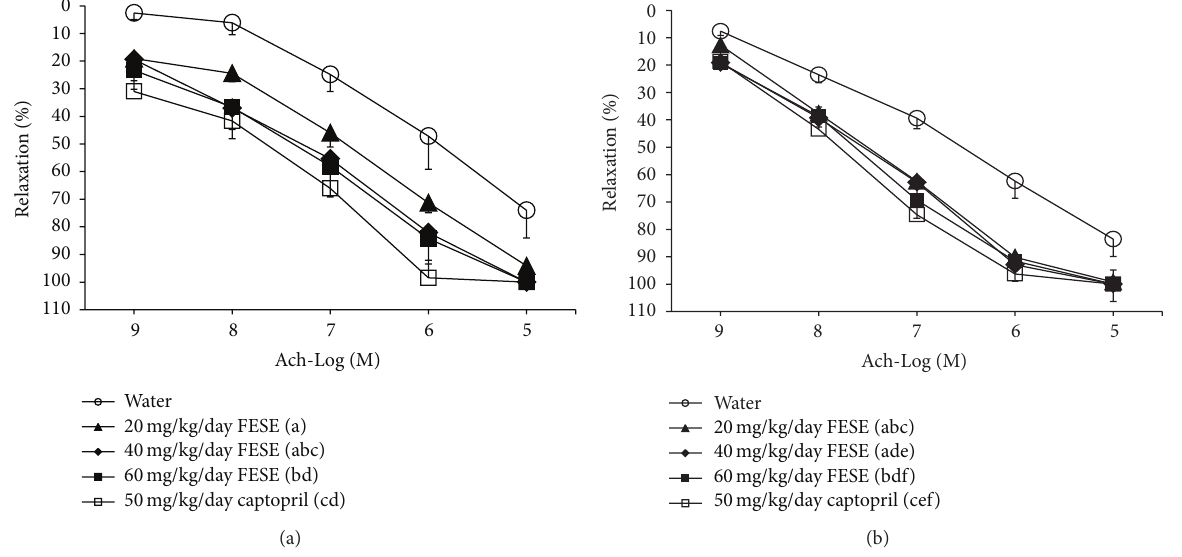
Figure 6: Cumulative concentration-response curves to acetylcholine (Ach) of aorta rings preconcentrated with 10 −5 M methoxamine from 20- (a) to 24-week-old (b) spontaneously hypertensive rats. The animals had received (from weaning until the 20th week of life) different daily treatments: tap water, 20 mg/kg/day Fraxinus excelsior L. seed extract (FESE), 40 mg/kg/day FESE, 60mg/kg/day FESE, or 50 mg/kg/day captopril. All rats drank tap water from the 20th week of life until the 24th week of life (follow-up period). Data are mean values ± SEM for a minimum of 8 experiments. Similar letters represent no statistical differences ( 𝑃 > 0.05 ). 𝑃 estimated by one-way